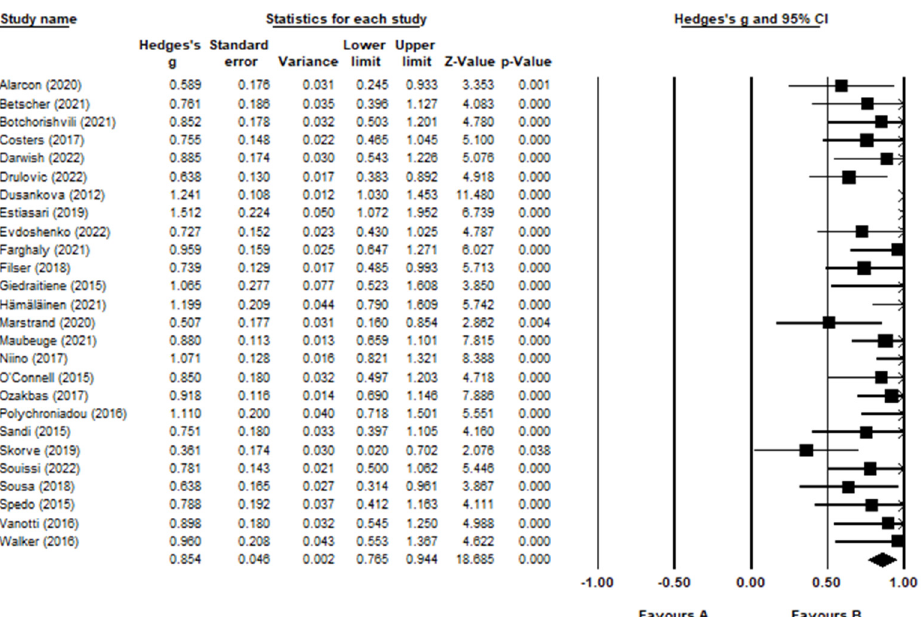
Figure 2. Forest plot for SDMT. Alarc ó n et al. [46]; Betscher et al. [47]; Botchorishvili et al. [48];